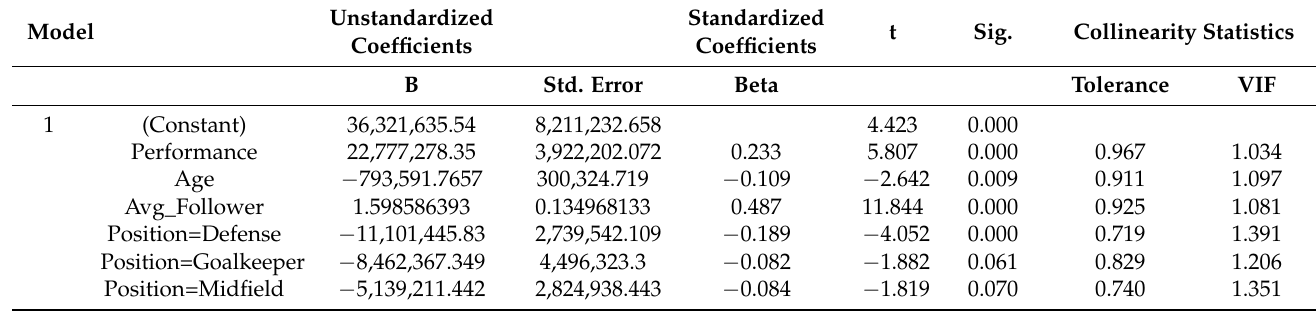
Table 3. Multivariate regression of market values of football players. Coefficients a